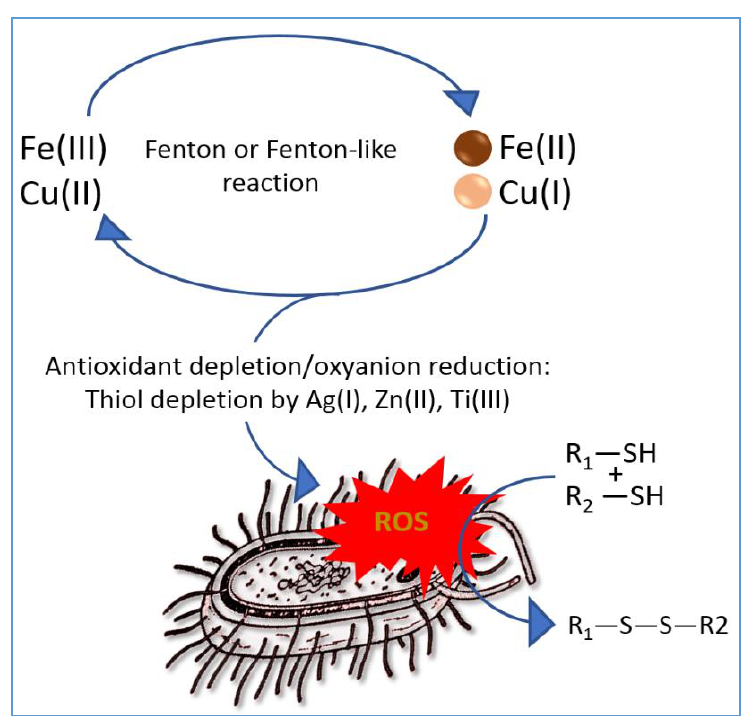
Figure 9. Schematic of Fenton chemistry due to ions of Fe(III) or Cu(II) associated with ROS intermediates leading to thiol depletion in the bacteria and virus topmost layers.